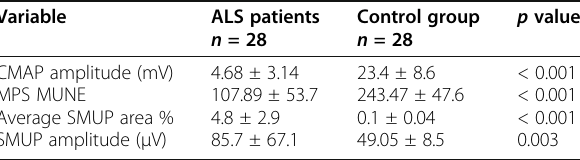
Table 2 The differences in the MPS MUNE, CMAP amplitude, and average SMUP area between ALS patients and